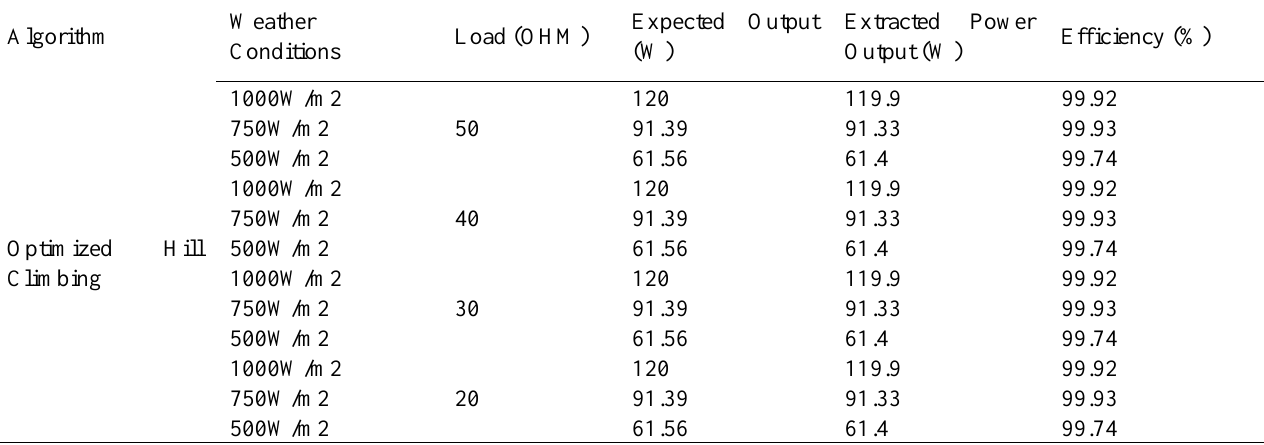
Fig. 7. Performance of the optimized hill climbing algorithm under changing weather conditions